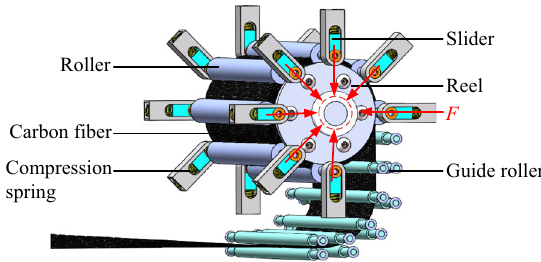
Figure 2 Drive and antiblossoming structure